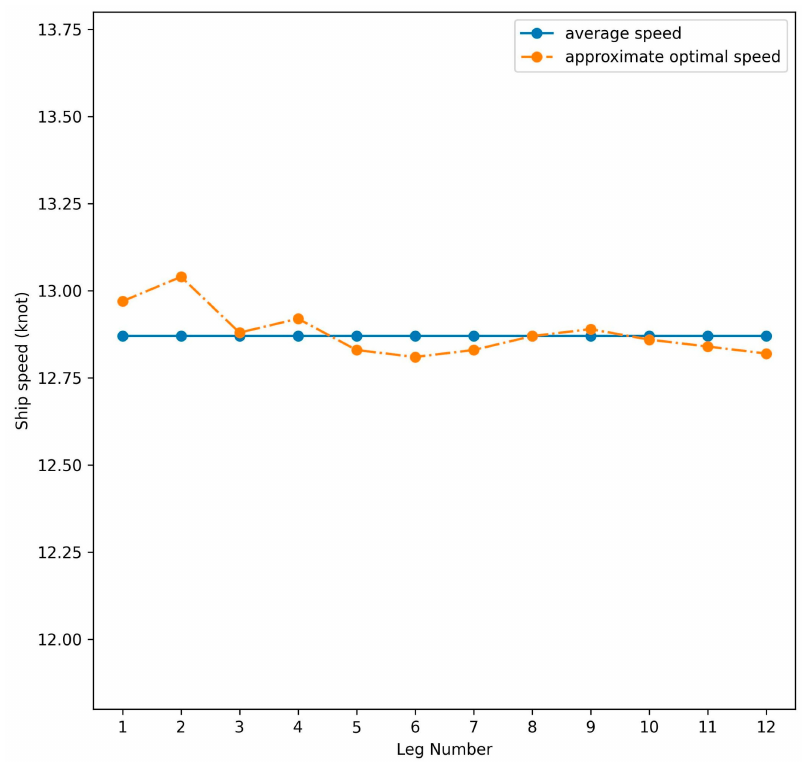
Figure 7. Theoretical average speed (blue, solid line) and approximate optimal speed (orange, dash-dotted line) in all legs for both a general single-fuel ship and a general dual-fuel